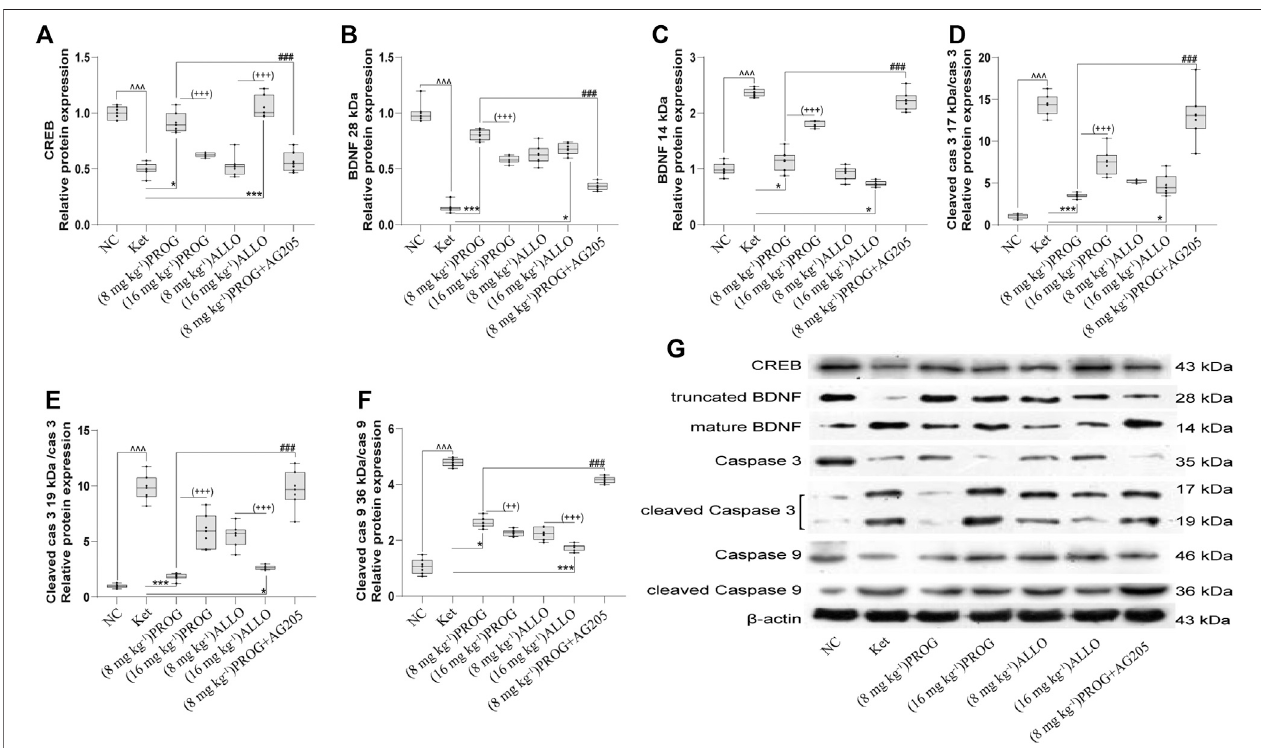
FIGURE 4 | Basal CREB/BDNF/caspase-3/9 protein expression in the hippocampus. (A) CREB, (B) truncated BDNF, (C) mature BDNF, (D) cleaved caspase-3 (17 kDa)/caspase-3, (E) cleavedcaspase-3(19 kDa)/caspase-3, (F) cleavedcaspase-9/caspase-9.Arepresentativeblotisshownin (G) .Dataareexpressedasmean ± SD, n (cid:2) 7foreachexperimentalgroup. ^ p < 0.05, ^^ p < 0.01,and ^^^ p < 0.001forKetvs.NC.* p < 0.05, ** p < 0.01and *** p < 0.001foradd-onofPROGandALLOvs.Ket. # p